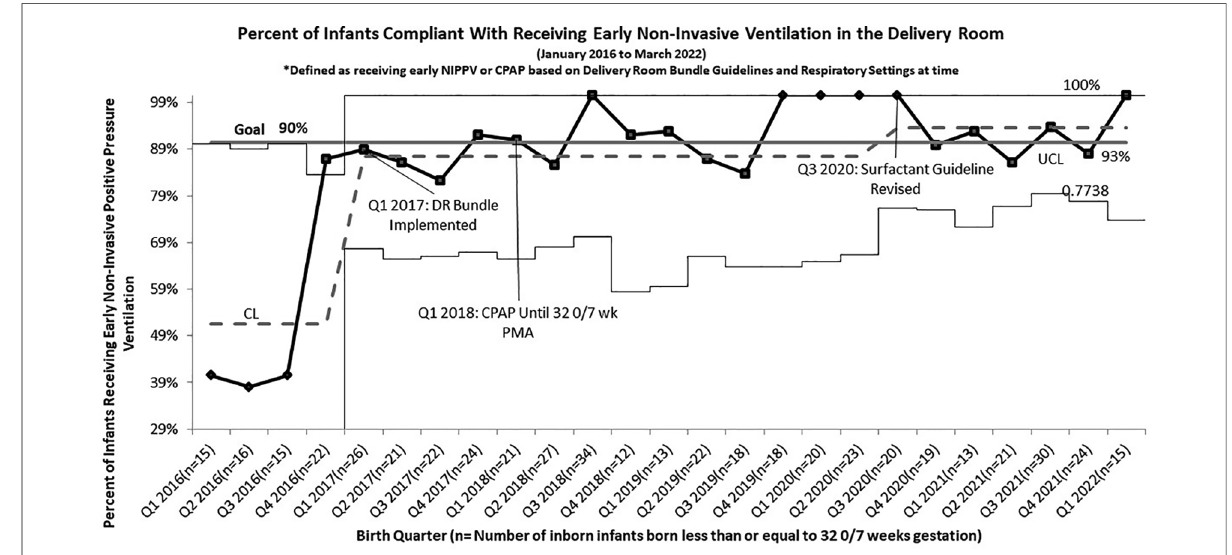
FIGURE 1 P chart of compliance with delivery room bundle for infants born less than or equal to 32 0/7 weeks gestation who received early continuous Non- invasive positive pressure by